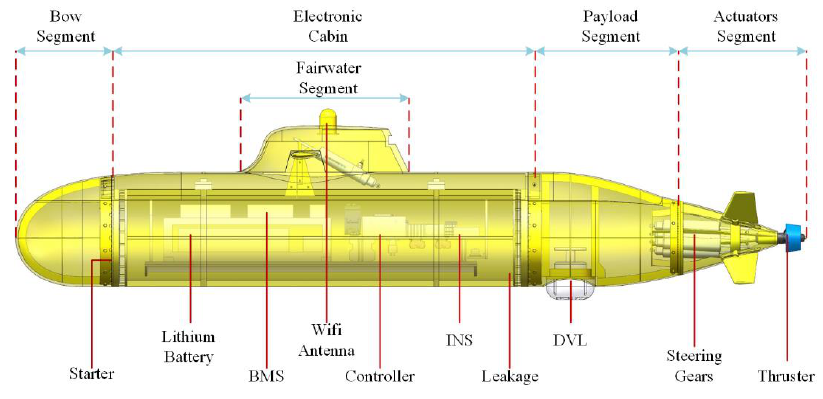
Figure 1. The xAUV sailing in the towing tank. ( 1 ) Portable surface monitor; ( 2 ) Surface WIFI antenna; ( 3 ) xAUV; ( 4 ) Integrated WIFI&GPS antenna.